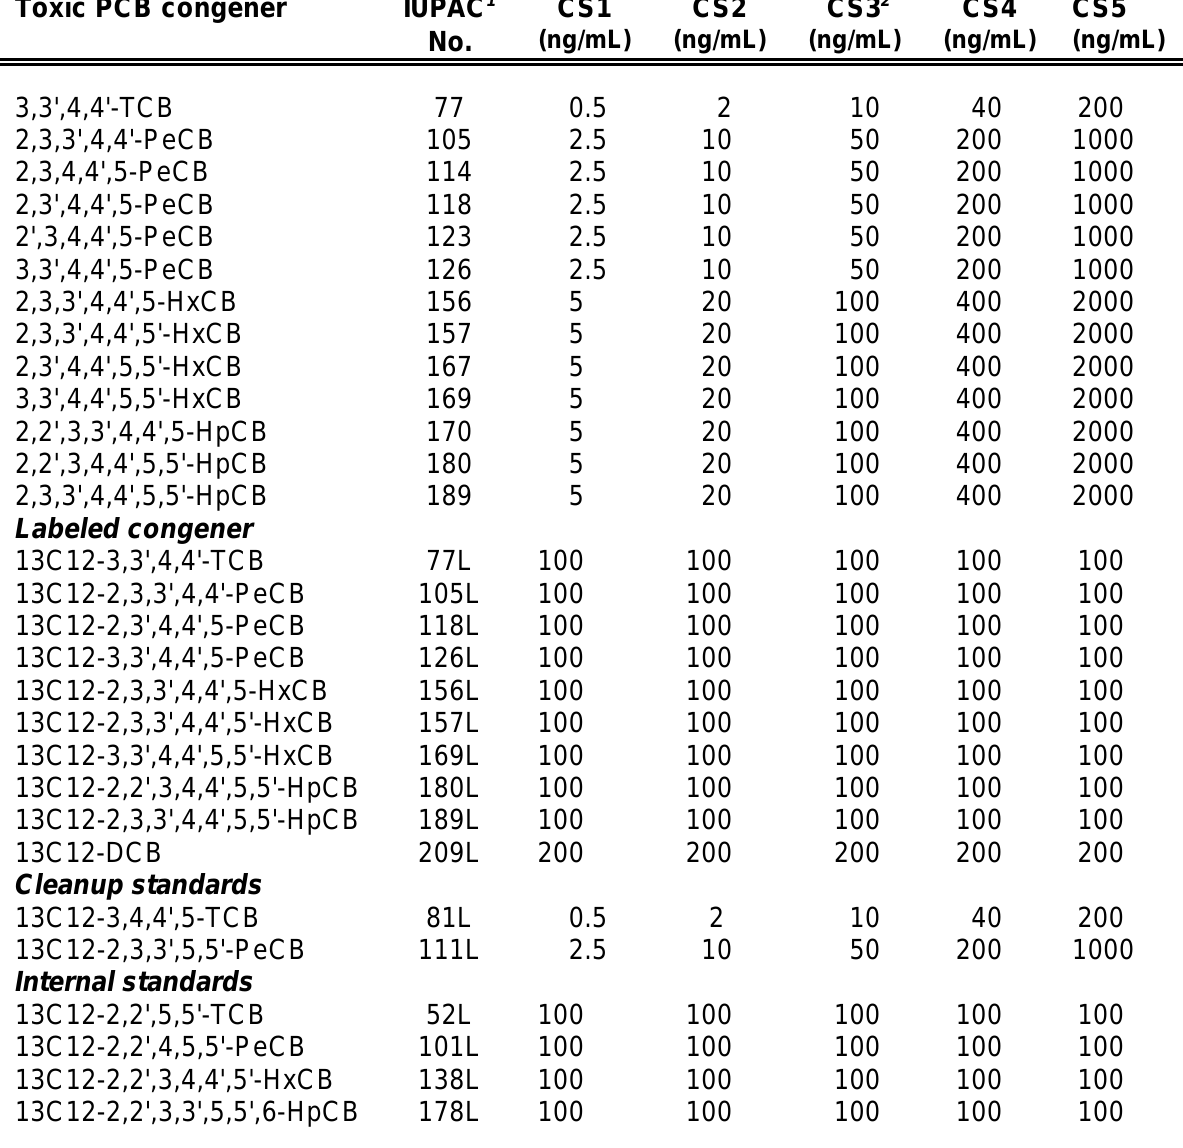
Table 4. Concentrations of PCBs in Calibration and Calibration Verification Solutions Toxic PCB congener